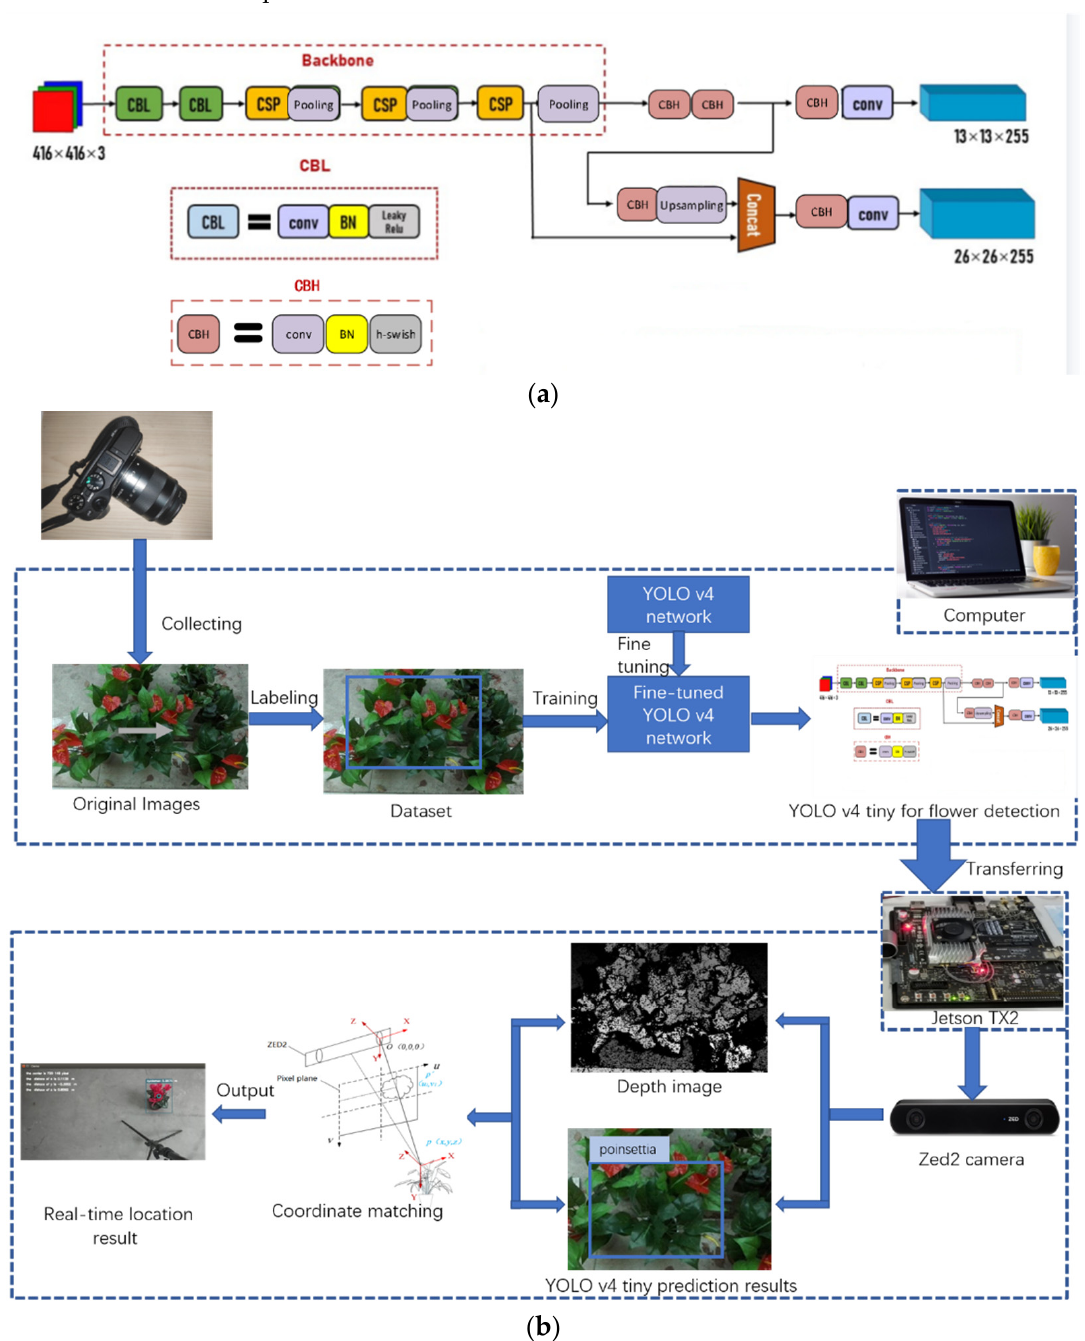
Figure 1. The processes for the potted flower detection and location based on YOLO V4-Tiny. ( a ) The YOLO V4-Tiny model. ( b ) The flowchart of the detection and location.